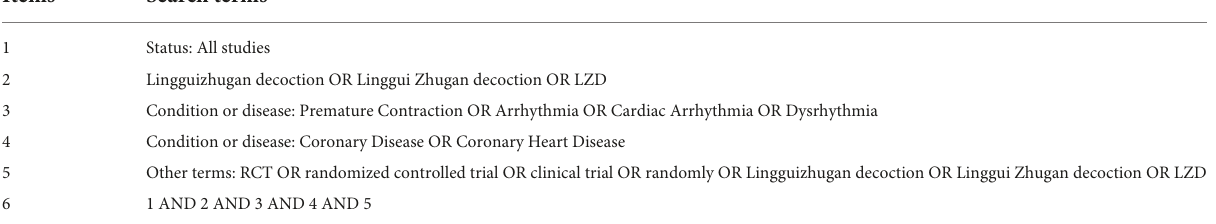
TABLE A8 ClinicalTrials.gov search